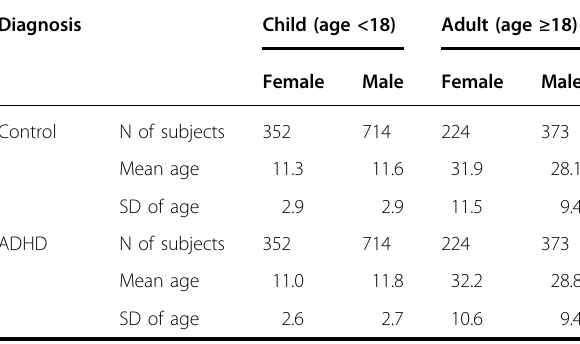
Table 1 Training set sample characteristics